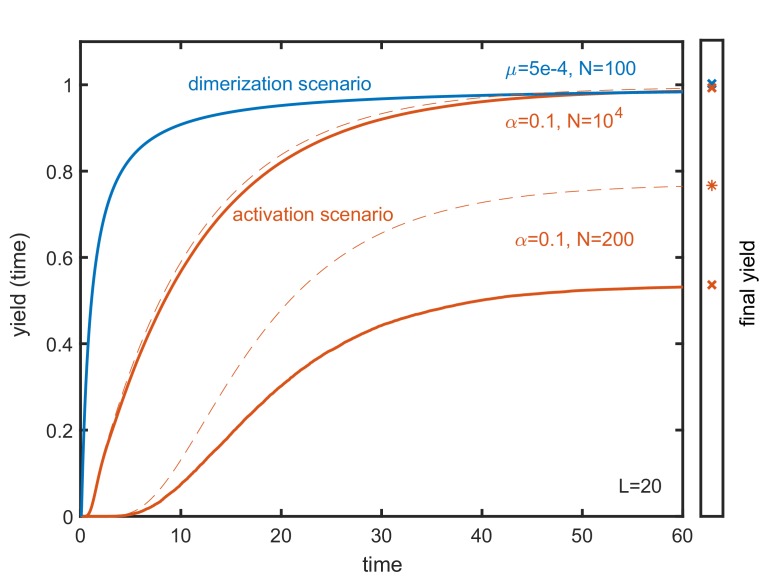
Time evolution of the yield in the activation and dimerization scenario.The time dependence of the yield is depicted for a dimerization scenario (blue) with μ=5×10-4 and N=100 and for two activation scenarios (red) with α=0.1 and N=2×102 and N=104, respectively, for target structures of size L=20. Drawn lines show the time evolution of the stochastic systems while dashed lines describe the time evolution in the corresponding deterministic systems (where the final yield may be higher in the activation scenario). In all cases the yield increases monotonically with time. The final yield, that is indicated in the right bar, represents the upper limit of the yield at any time. Yield production in the activation scenario is generally more gradual than in the dimerization scenario. Therefore, the dimerization scenario is, in general, more time efficient than the activation scenario.